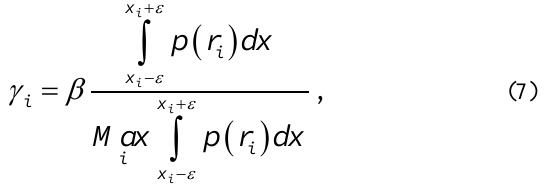
Table 1. Procedure for 𝛍̃ 𝐥 calculation. 1. Set an adjacency radius per test sample to distinguish the adjacent samples. The adjacency radius is a coefficient of class 𝜃 𝑙 bandwidth. 2. Count the number of samples belonging to class 𝜃 𝑙 .